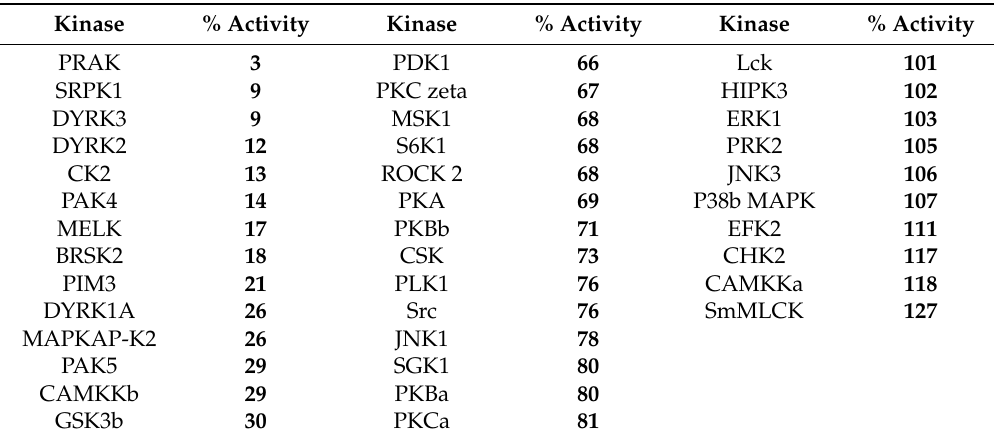
Table 1. Selectivity profiles of ellagic acid on a 70 kinase panel. Residual Casein kinase II (CK2) activity (determined at 10 µ M Ellagic Acid concentration) is expressed as a percentage of the control activity without inhibitor. Activities <25% of control are highlighted in grey. Conditions for the activity assays are described in